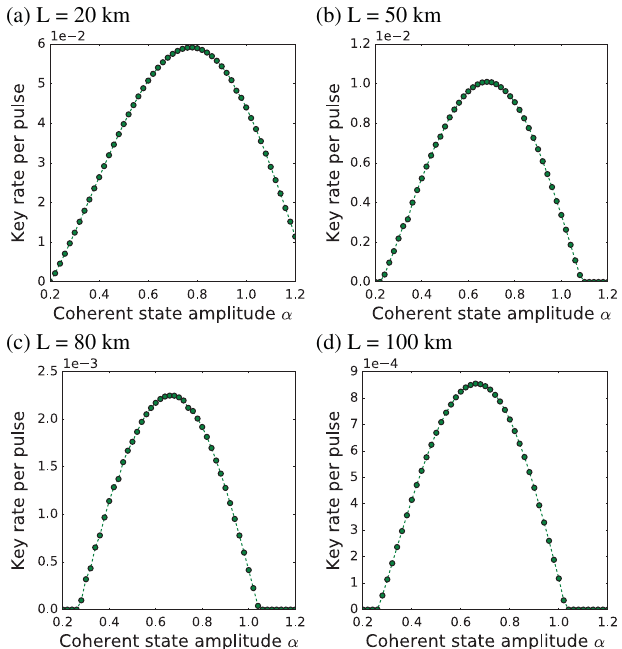
FIG. 6. Secure key rate for protocol 2 versus the coherent state amplitude α for selected choices of distances (a) L ¼ 20 km, (b) L ¼ 50 km, (c) L ¼ 80 km, and (d) L ¼ 100 km with the excess noise ξ ¼ 0 . 01 and reconciliation efficiency β ¼ 0 . 95 .